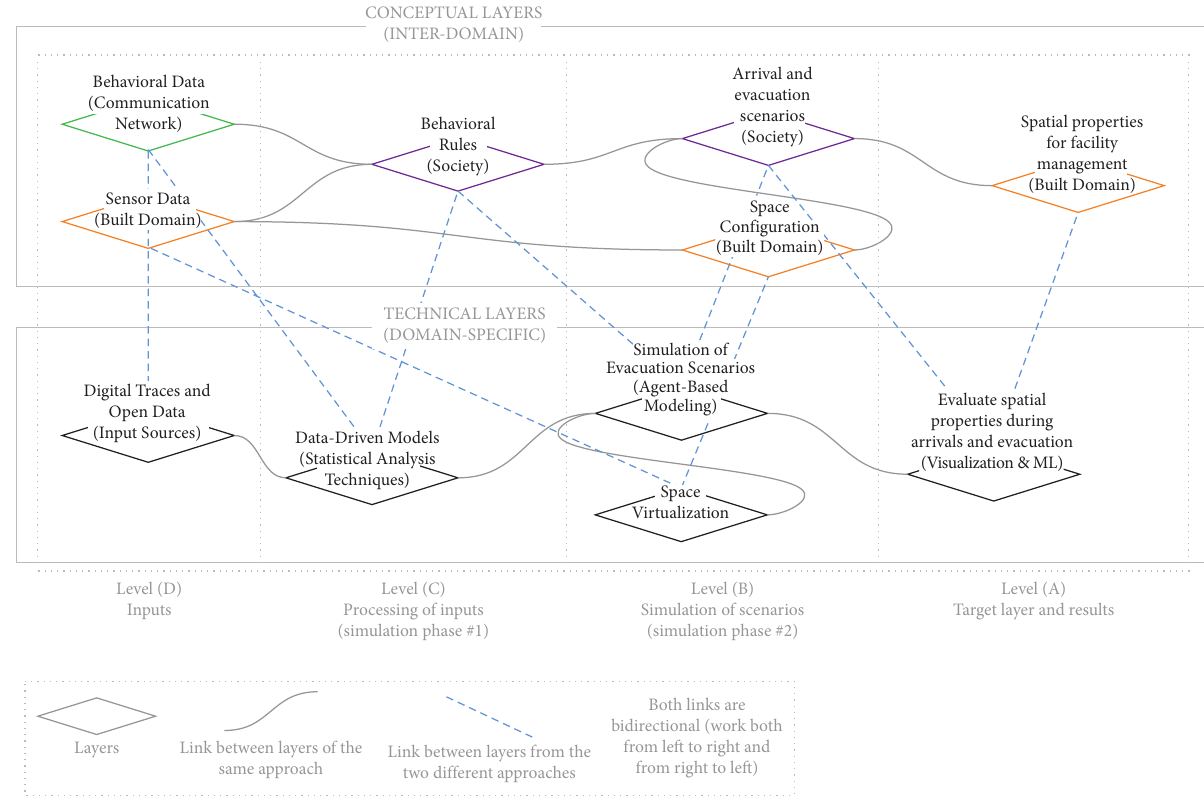
Figure 2: How both the conceptual and the technical layers assemble into the interdomain and the domain-specific approaches? The modularity of the framework is such that both the content and the quantity of levels may vary, adaptable to each specific case study. The process of arranging the layers together is not linear, and the two approaches are built up at the same time. The dashed lines show the link between conceptual and technical layers: the conceptual layers are the output of the process defined in the technical layers. The diagram can be structured in both directions, from level A to D and vice